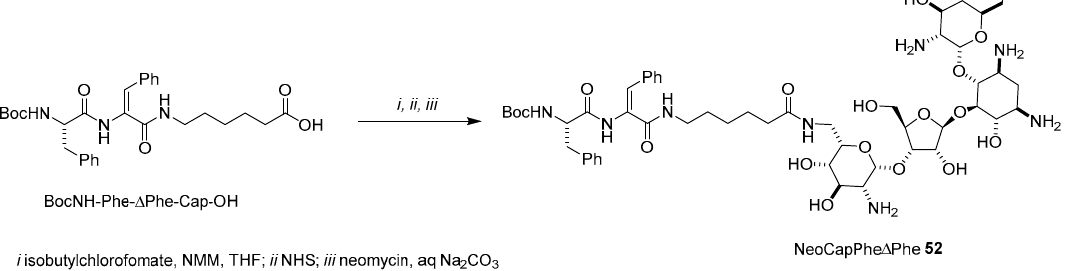
Figure 15. Synthesis of NeoCapPhe Δ Phe 52 .